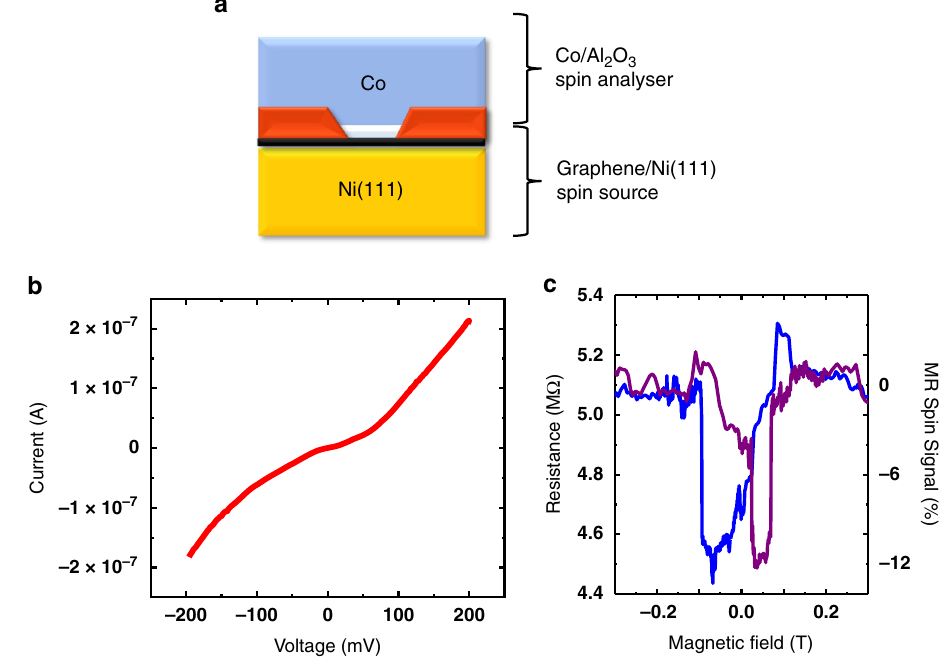
Fig. 2 Analysis of the spin properties of the Ni(111)/graphene electrode. a Scheme of the full device con fi guration. After the opening of small micrometric junctions by a lithographic step, top reference Al 2 O 3 /Co spin analyzer is deposited by ALD followed by sputtering. b Non-linear dc I – V characteristics show the expected tunneling behavior of the Al 2 O 3 /Co spin analyzer and c magneto-transport dc measurements reveal a − 12% TMR spin signal. The epitaxial Ni (111)/graphene electrode is thus shown to produce a strong spin fi ltering